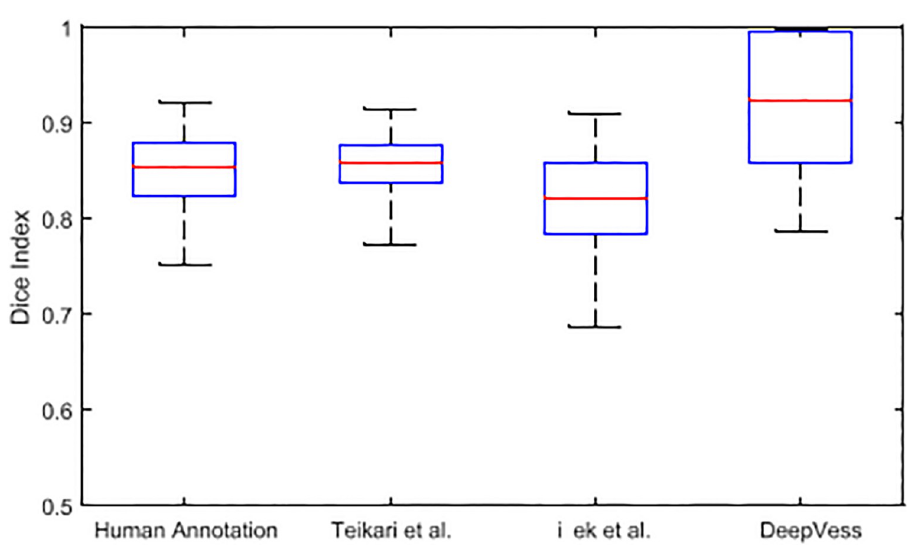
Fig 3. Slice-wise Dice index of DeepVess vs. manual annotation by a trained person and the state-of-the-art methods [24, 28] compared to the gold standard of the expert human annotation. The central red mark is the median, and the top and bottom of the box is the third and first quartiles, respectively. The whiskers indicates the range of data. DeepVess has higher median value in comparison to the Teikari et al. [24], C¸ic¸ek et al. [28], and the human annotator (Wilcoxon signed-rank test, p = 2.98 e − 23, p = 2.59 e − 32, and p = 2.8 e − 28, respectively).